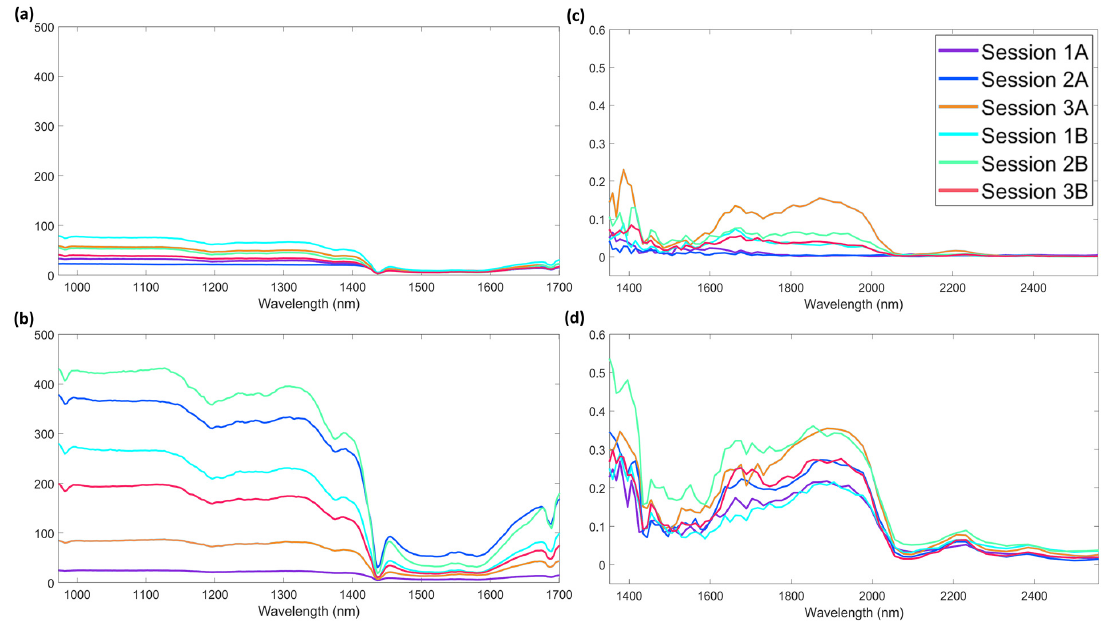
Figure 6. Diagonal of the error covariance matrices calculated over session replicates for AvaSpec- Mini-NIR data: ( a ) sugar lump spectra ( b ) granulated sugar spectra and for NeoSpectra Scanner data: ( c ) sugar lump spectra ( d ) granulated sugar spectra.